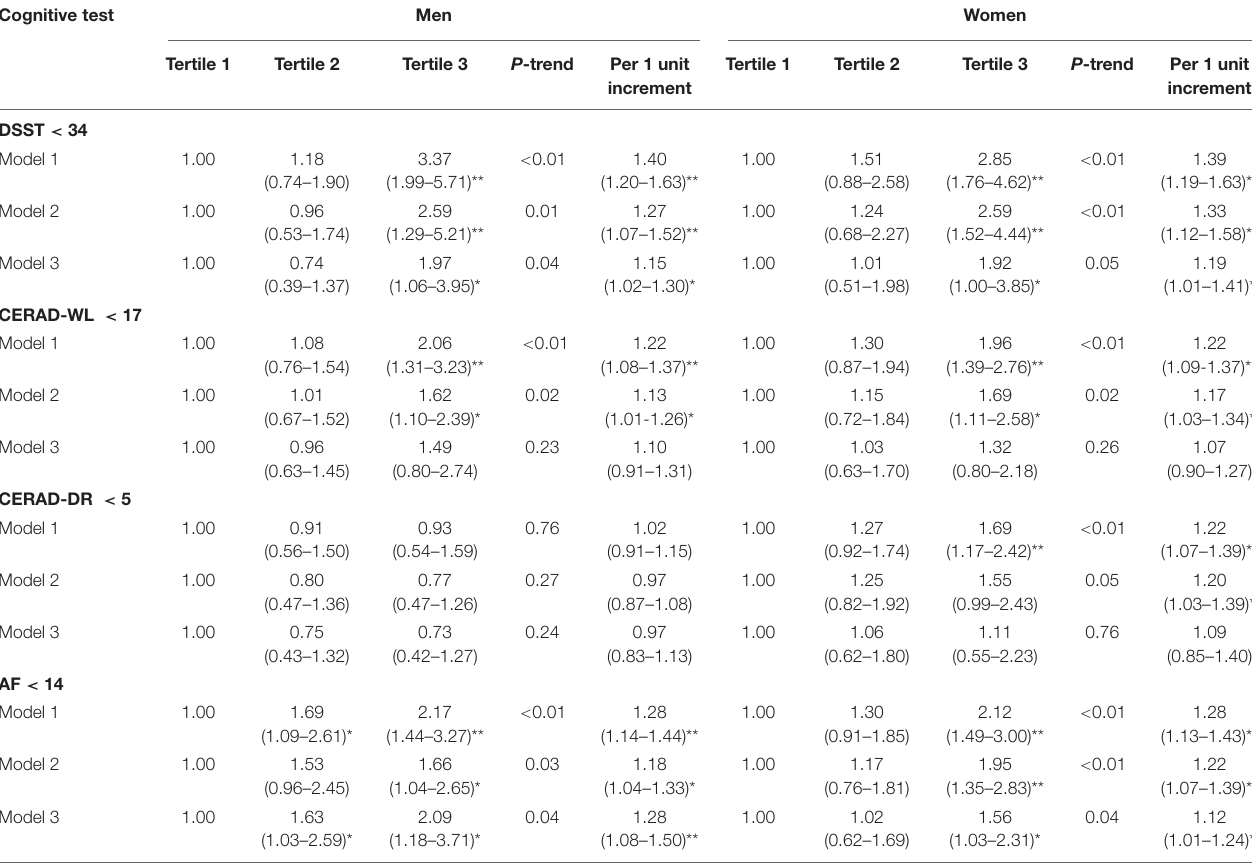
TABLE 3 | Odds ratios (95% confidence intervals) of lower cognitive functioning by tertiles of dietary inflammatory index score and by sex. Cognitive